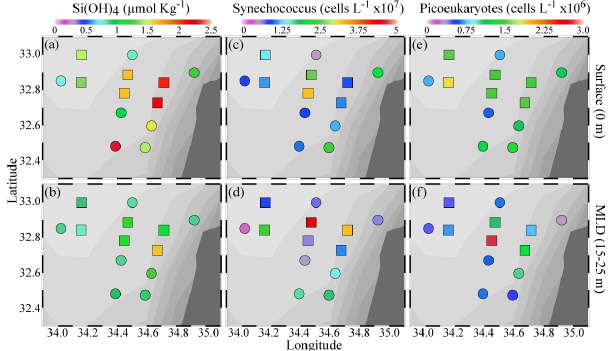
Fig. 7. Spatial distribution of (a) , (b) Si(OH) 4 concentrations; (c) , (d) Synechococcus and (e) , (f) picoeukaryote abundance at the sur- face (upper panels) and mixed-layer depth (lower panels). Squares and circles mark stations located in and out of the patch, respec- tively (see Fig. 3 for station numbers). Figure was made using Ocean Data View (Schlitzer, 2011).